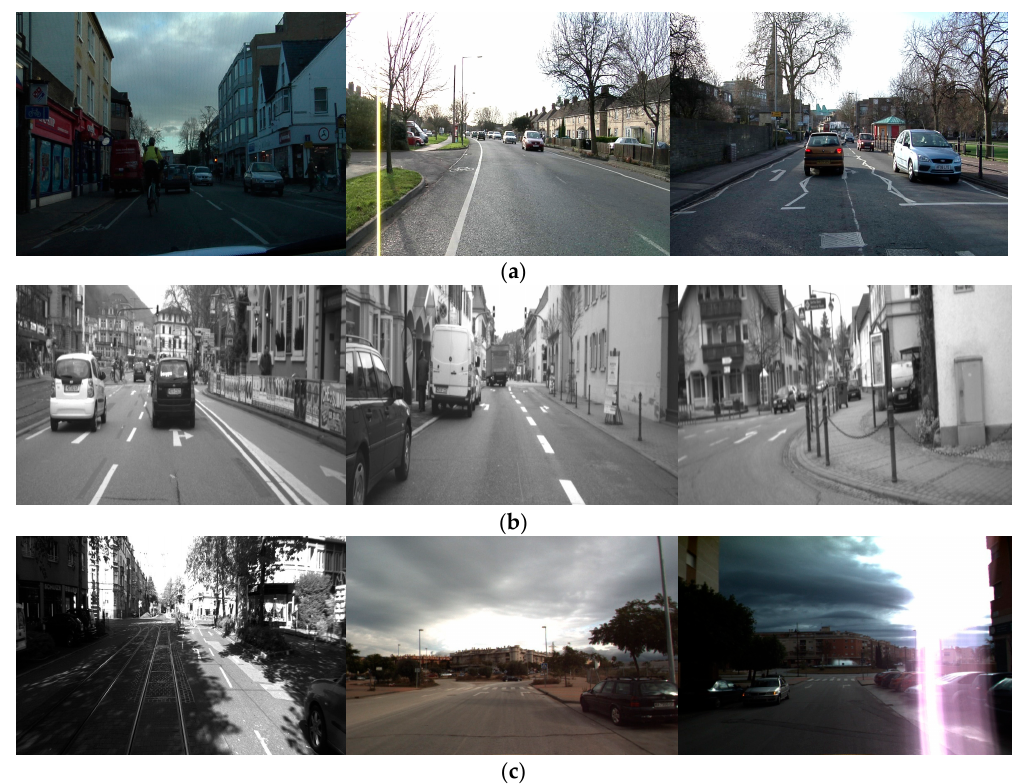
Figure 7. Examples of images from the open datasets. ( a ) Cambridge dataset. ( b ) Daimler dataset. ( c ) Malaga urban dataset.